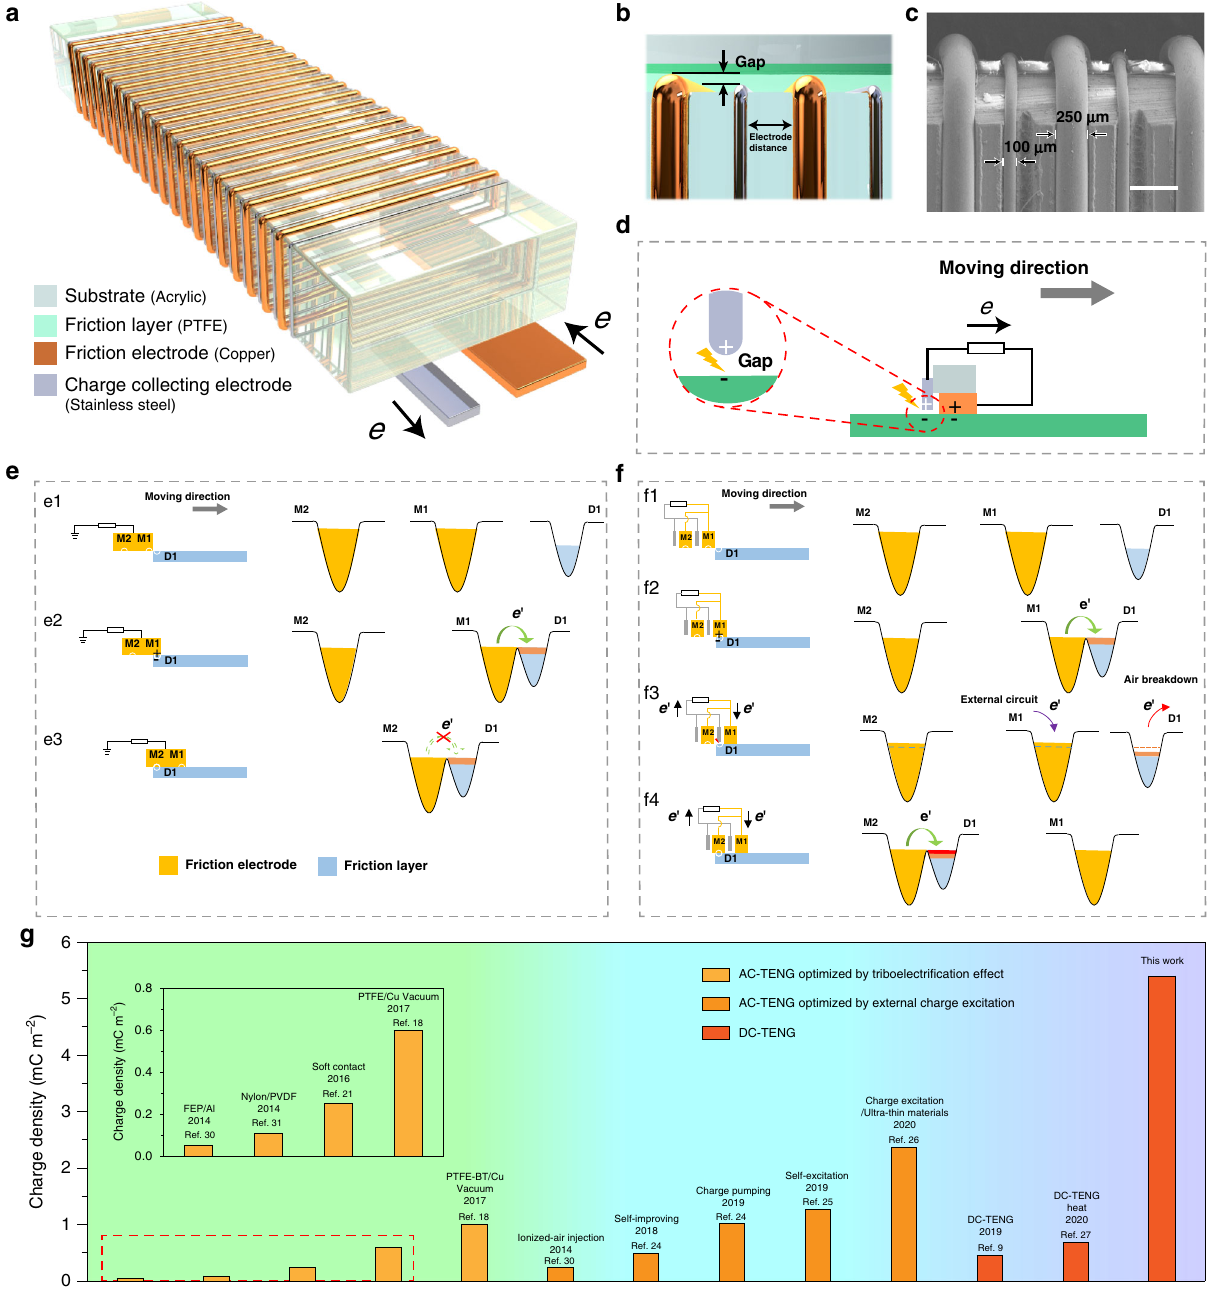
Fig. 1 Structural design and working mechanism of MDC-TENG. a , b Structural schematic and c SEM image of MDC-TENG (scale bar: 500 μ m). d Schematic diagram of DC-TENG working mechanism. The schematic diagram of electrons transition process e without and f with microstructure optimization. g Comparison of the charge density of MDC-TENG with different type